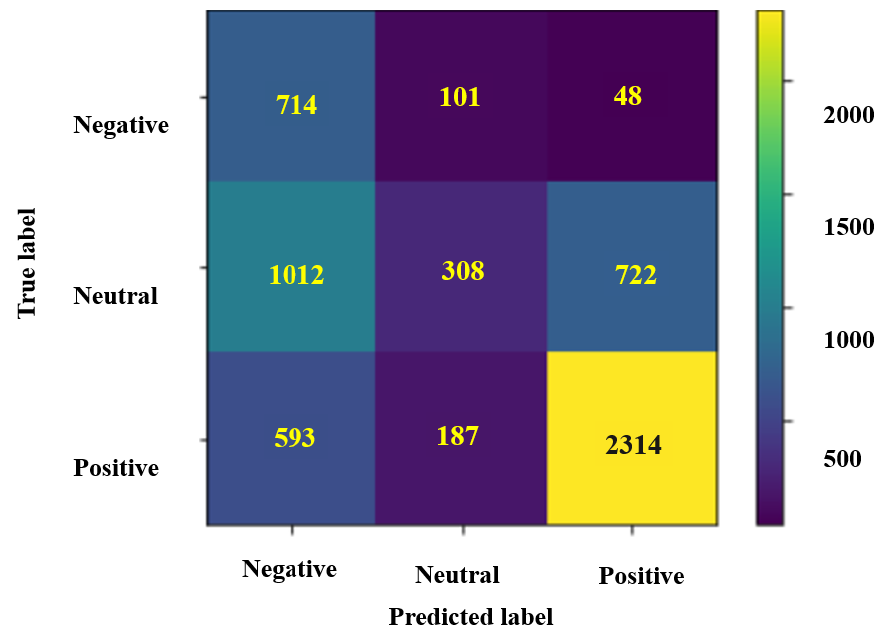
Figure 6. Confusion matrix of 3-class (negative, neutral and positive) classification.